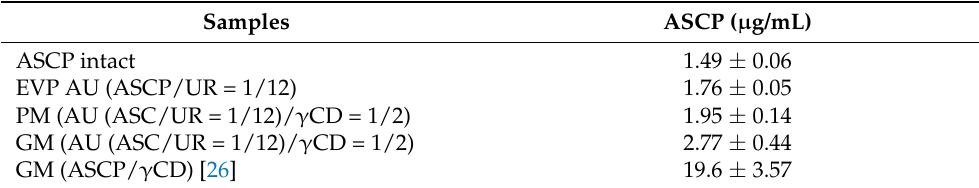
Table 1. Solubility of AU (ASCP/UR = 1/12)/ γ CD systems. Samples ASCP ( µ g/mL) ASCP intact 1.49 ± 0.06 EVP AU (ASCP/UR = 1/12) 1.76 ± 0.05 PM (AU (ASC/UR = 1/12)/ γ CD = 1/2) 1.95 ± 0.14 GM (AU (ASC/UR = 1/12)/ γ CD = 1/2) 2.77 ± 0.44 GM (ASCP/ γ CD) [26] 19.6 ± 3.57 Results were expressed as mean ± S.D. ( n = 3) at 37 ◦